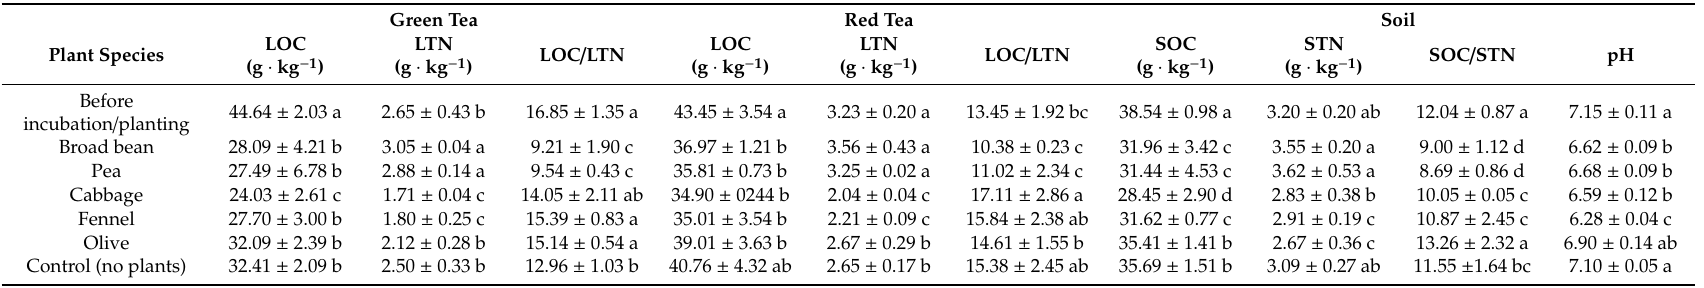
Table 3. Litter organic carbon (LOC), litter total nitrogen (LTN), and LOC / LTN ratio from the green tea and red tea bags; soil organic carbon (SOC), soil total nitrogen (STN), SOC / STN ratio, and soil pH. Each value represents the mean ( ± SD) of five replicates (composite soil samples; n = 5) for each species. The values followed by di ff erent letters (a–d) are statistically di ff erent ( p ≤ 0.01) within